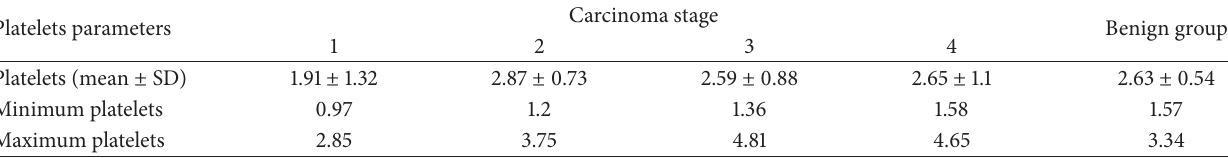
Table 5: Relation of platelets parameters with four stages of carcinoma and benign